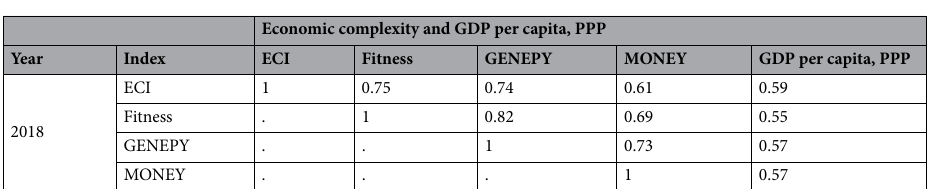
Table 1. Kendall rank correlation coefficient τ k for economic complexity indices (ECI, Fitness, GENEPY and MONEY) and the GDP per capita, PPP. World trade at the HS-4